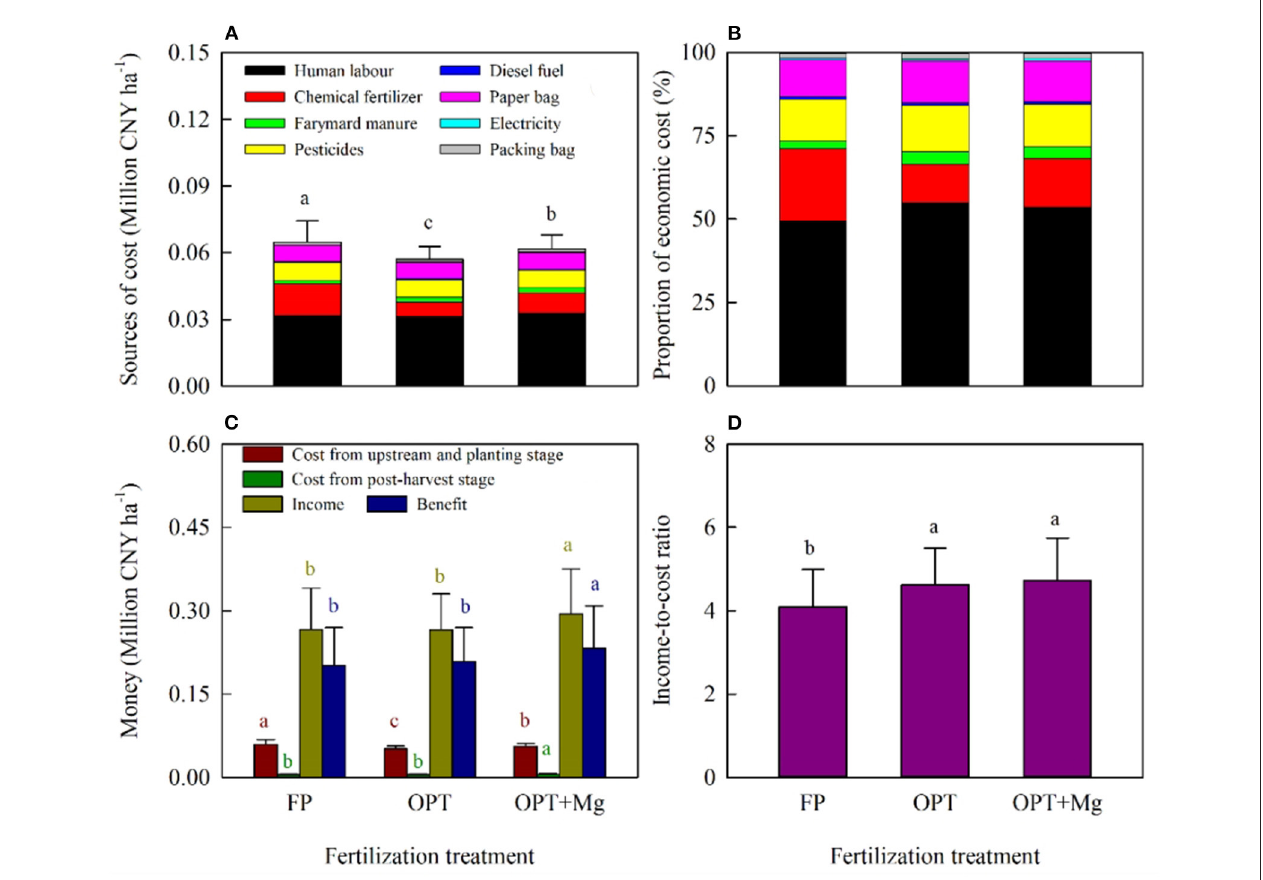
FIGURE 6 | Different sources (A) and proportions of economic costs (B) , costs and income (C) , and income-to-cost ratio (D) under different fertilization treatments in pomelo production. The black error bars in the figure indicate the overall standard deviations (SDs). Different letters above histogram bars indicate statistically significant differences at P <